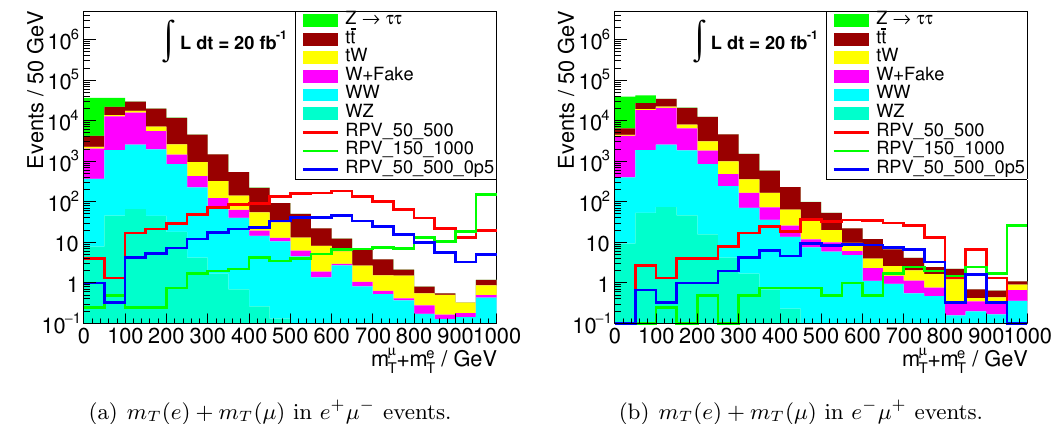
Figure 1 . The expected distributions of m T ( e ) + m T ( (cid:22) ) in events with OSDF leptons ( e + (cid:22) (cid:0) and e (cid:0) (cid:22) + in (a) and (b) respectively).